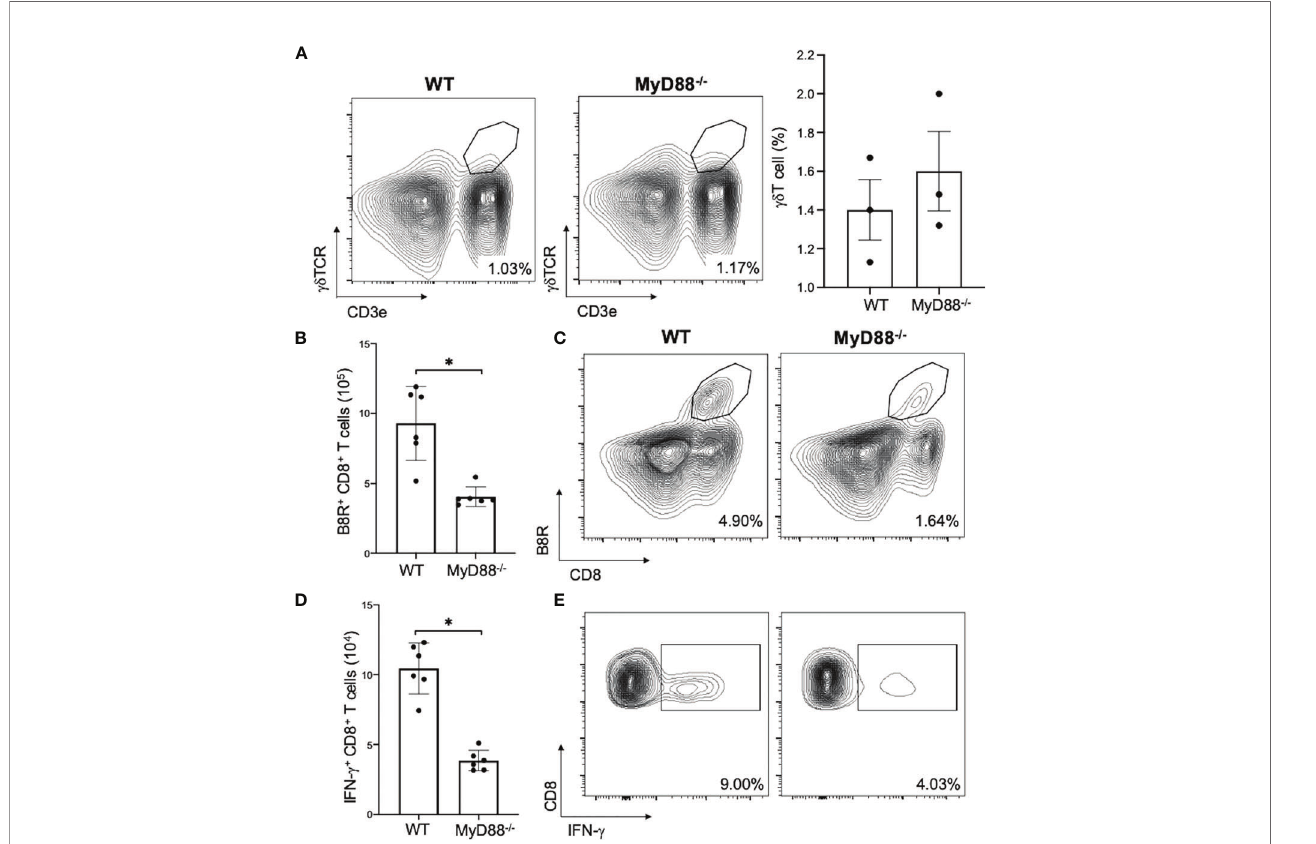
FIGURE 7 | MyD88 is required for CD8 + T cell activation by gd T cells. d TCR -/- mice were adoptively transferred with WT or MyD88 -/- gd T cells and inoculated with VV. (A) 3 days after inoculation, splenocytes were analyzed for gdT cells by FACS plots and percentages of gdT cells are shown. 7 days after inoculation, splenocytes were obtained and stained for CD8 + CD4 - lymphocytes and plotted via fl ow cytometry for B8R + CD8 + T cells (B, C) or IFN- g + CD8 + T cells. (D, E) Unpaired student T-test, *P < 0.005. Each panel is representative of 3 independent